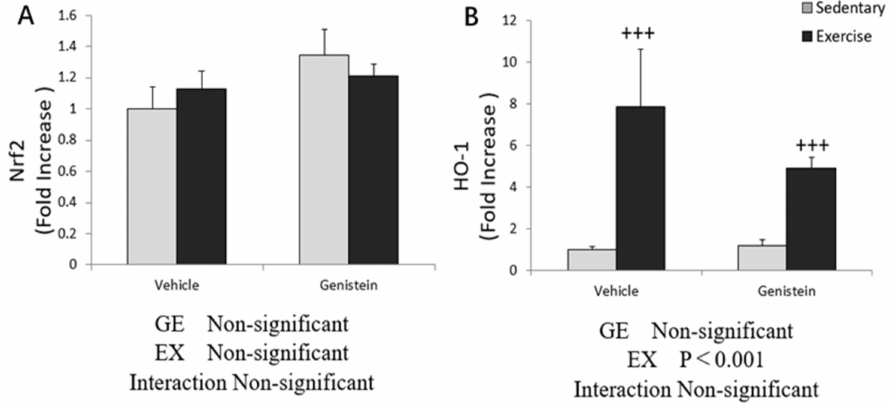
Figure 10. ( A ) Nrf 2 mRNA (Con, n = 8; GE, n = 7; Ex, n = 7; GE + EX, n = 7); ( B ) HO-1 mRNA (Con, n = 8; GE, n = 7; Ex, n = 7; GE + EX, n = 7), vehicle: non-supplemented groups (only administrated with 0.5% CMC-Na solution); GE: GE-supplemented groups. +++ p < 0.001, the main effect of exercise. Values are means ±